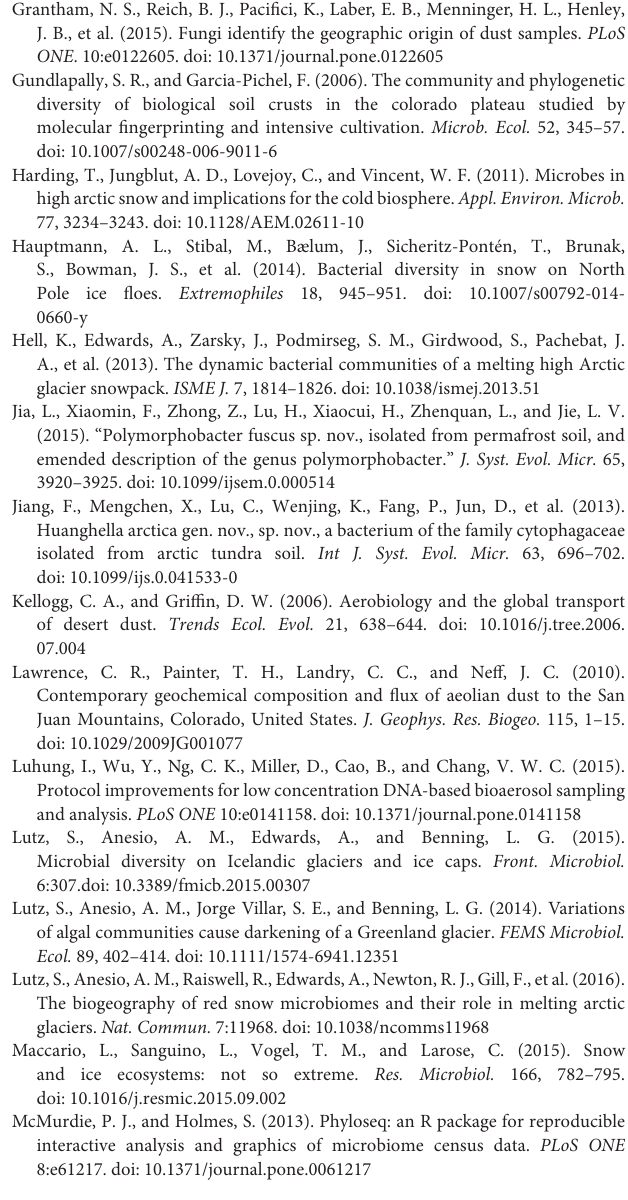
merged layer, SASP ALM refers to the Swamp Angel Study Plot merged layer, and SASP IDL refers to the Swamp Angel Study Plot individual dust layer from